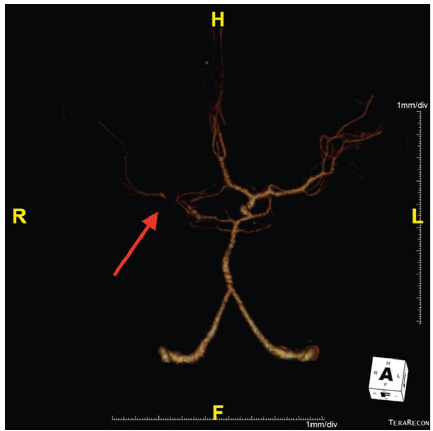
Figure 1: Diffusion weighted imaging (DWI) sequence demon- strating restricted diffusion in the right MCA territory of the basal ganglia and temporal lobe.